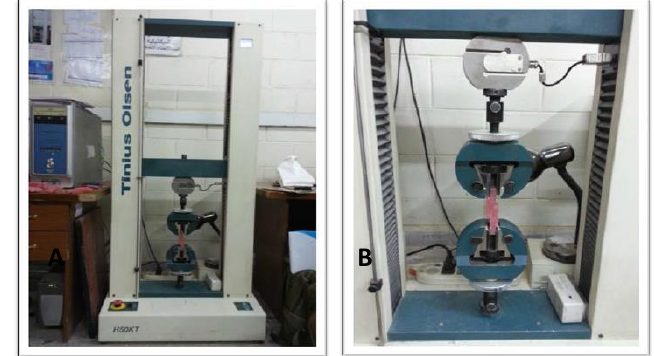
Figure 7: (A) Universal Instron machine (B) Shear bond strength specimen